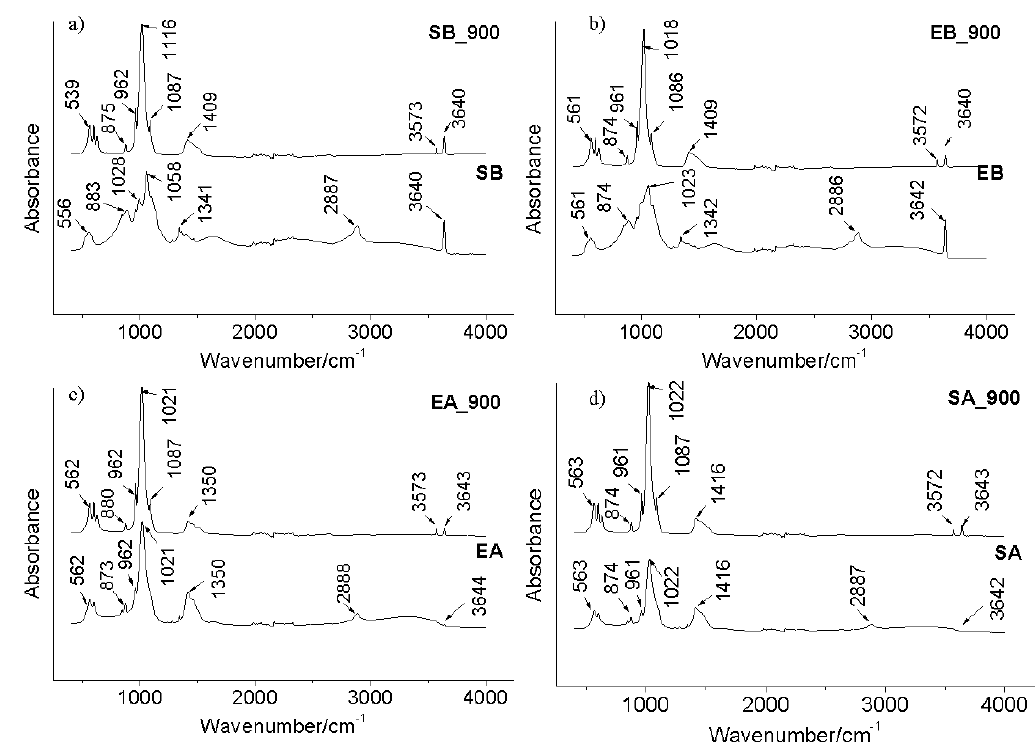
Figure 4. FTIR spectra of the samples: a) SB and SB_900, (b) EB and EB_900, (c) EA and EA_900, (d) SA and